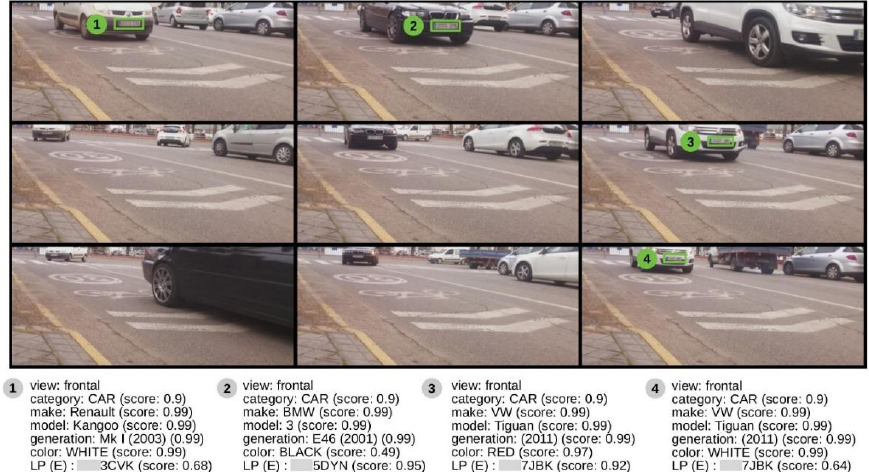
Figure 7. Detection of vehicles in a 3 × 3 image matrix, which allows, by means of a single sending to the cloud, to summarize 9 s of traffic analysis of a given sensor. The system detects both the number